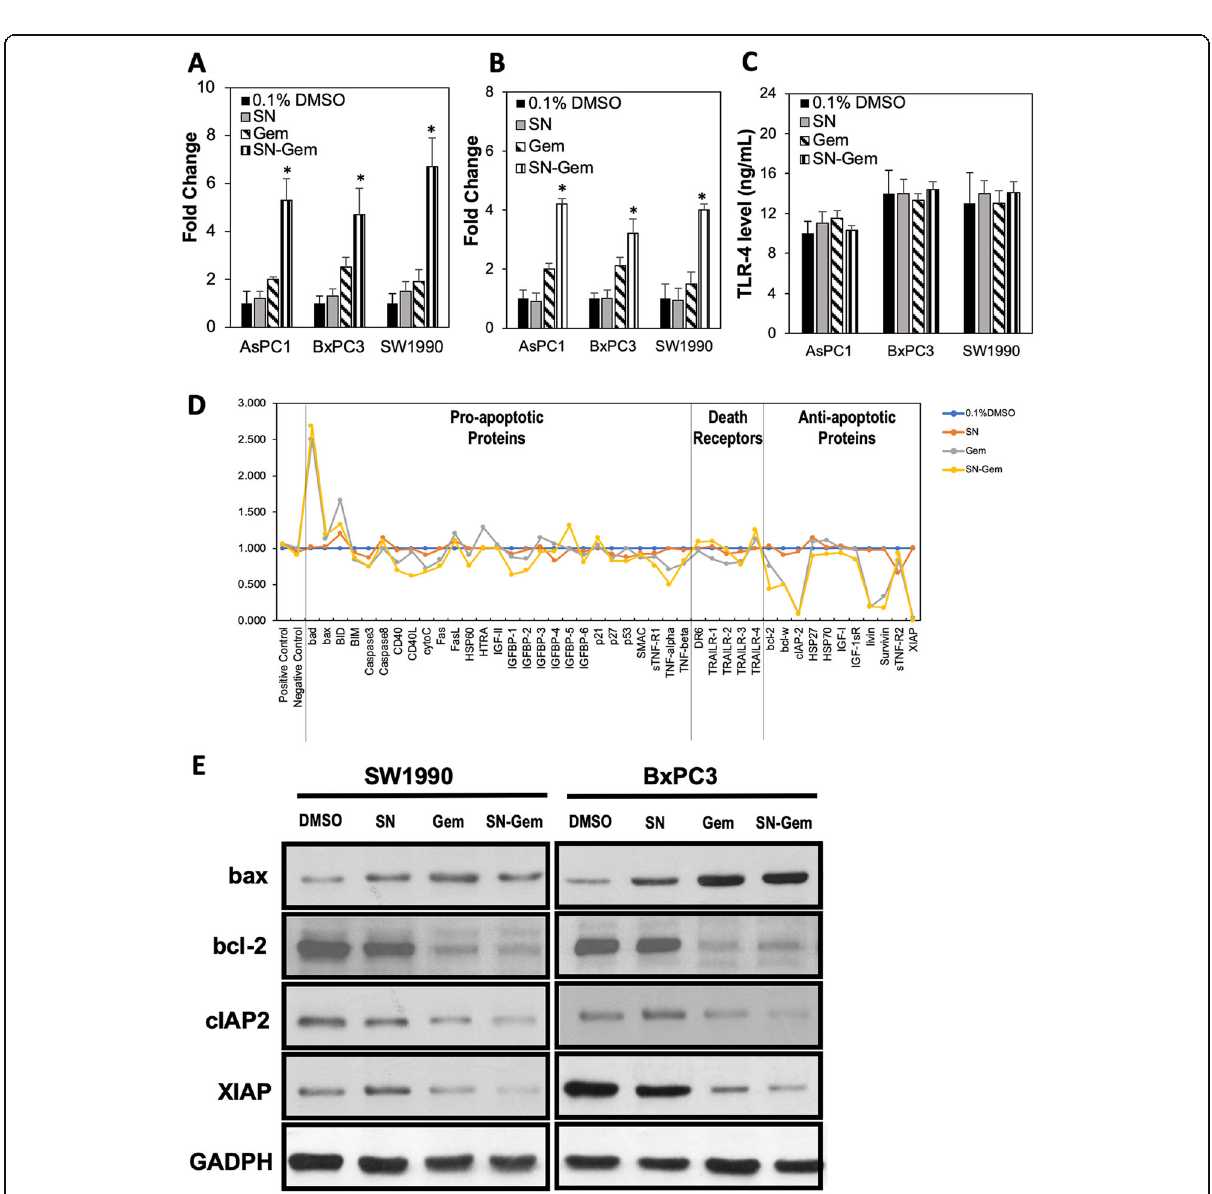
Fig. 3 Apoptotic effects of SN extracts and gemcitabine on PDAC cells. a AsPC1, BxPC3 and SW1990 were treated with 0.1% DMSO, SN extracts, gemcitabine, or combination of both SN extracts and gemcitabine. The cells were then harvested for apoptotic induction using ELISA assay.